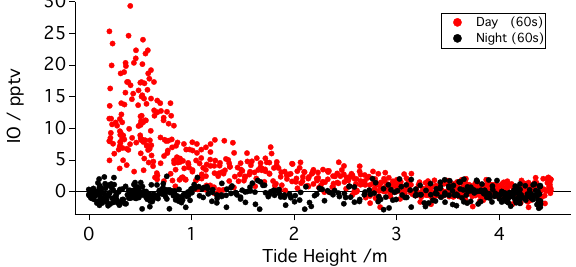
Fig. 5. IO mixing ratio observed by LIF (60s integration time) against tide height: day (red), night (black). A clear anti-correlation of IO with tide height can be seen during daylight hours but there is no tidal dependance at